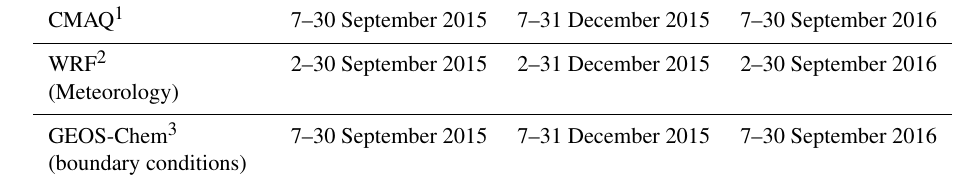
Table 7. Simulation